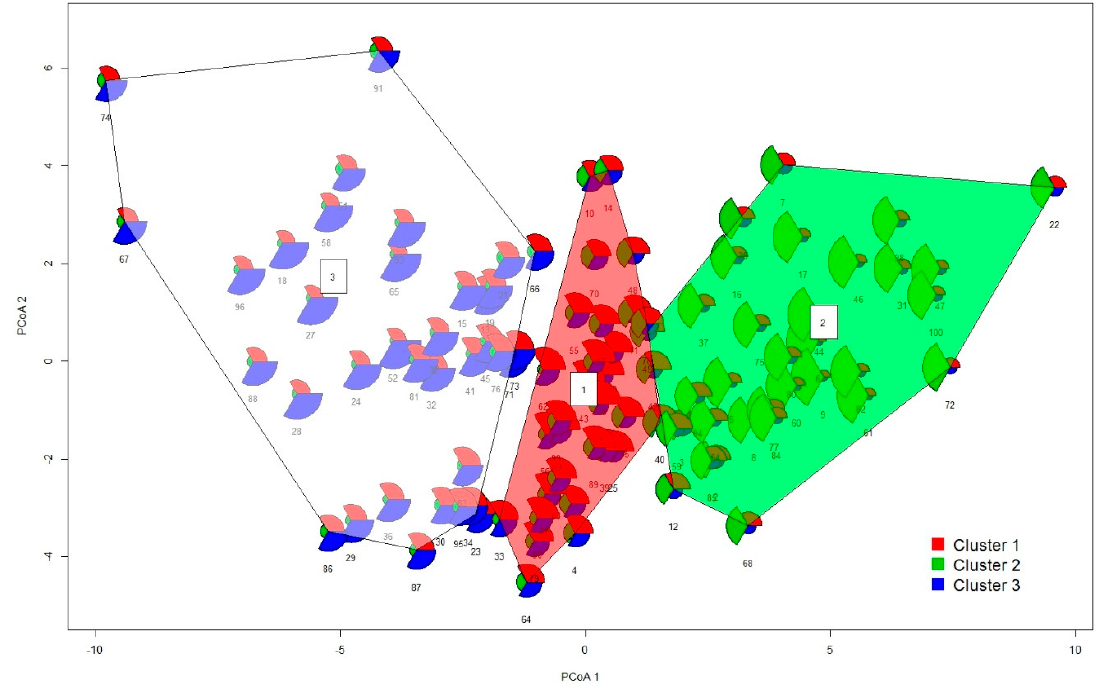
Figure 4. Membership probabilities and assigned cluster number in a graphical representation of principal coordinate analysis (PCoA) on Aitchison distances between sampling localities.